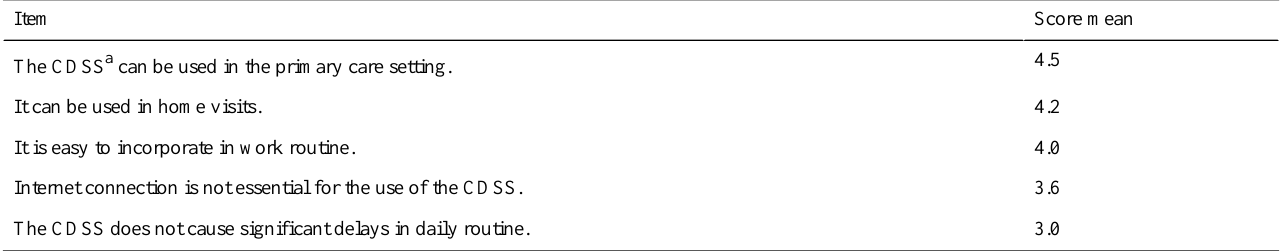
Table 3. Feasibility score on a 5-point scale by item